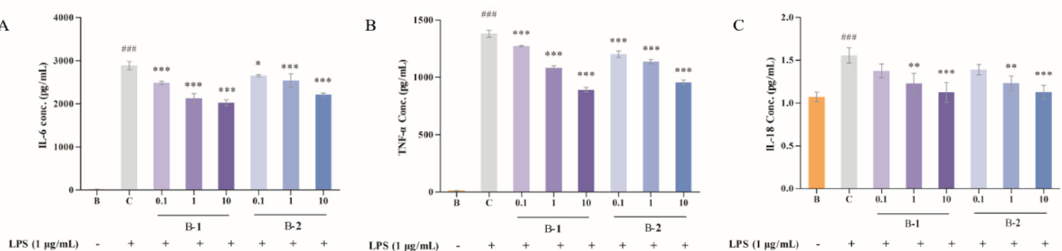
Figure 2. ( A ) IL-6 level of BV-2 cells treated by benzaldehydes 1 – 2 . ( B ) TNF- α level of BV-2 cell treated by benzaldehydes 1 – 2 . ( C ) IL-18 level of BV-2 cell treated by benzaldehydes 1 – 2 . Data are expressed as the means ± SD ( n = 3). ### p < 0.001 vs. normal control group, * p < 0.05, ** p < 0.01, and *** p < 0.001 vs. LPS induced group.